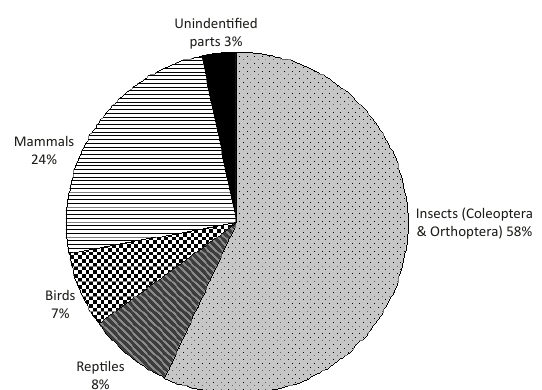
Figure 2. Diet composition of spotted owlets recorded from 52 regurgitated pellets collected in Cauvery Delta region during December 2007–February